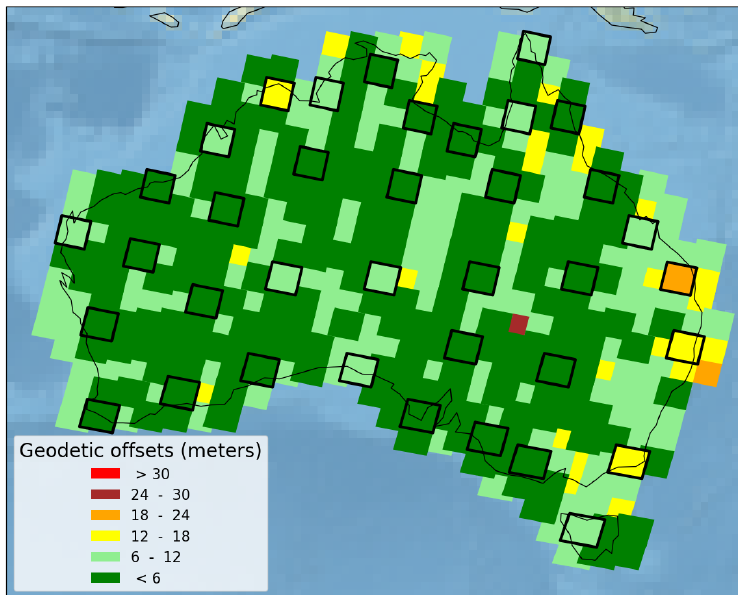
Figure 3. Plot of geodetic accuracy of Landsat 8 scenes after the free adjustment triangulation process. A small number indicates that the GLS GCPs are consistent with the pointing knowledge of the scenes, while a large number is likely to indicate an error in the scenes’ pointing knowledge, more so than any error in the adjustments to the GCPs. The block triangulation method thus highlights images that are not consistent with the block as a whole.